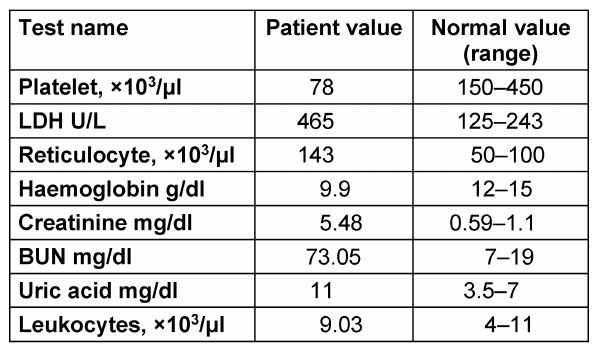
Table 1: Laboratory test